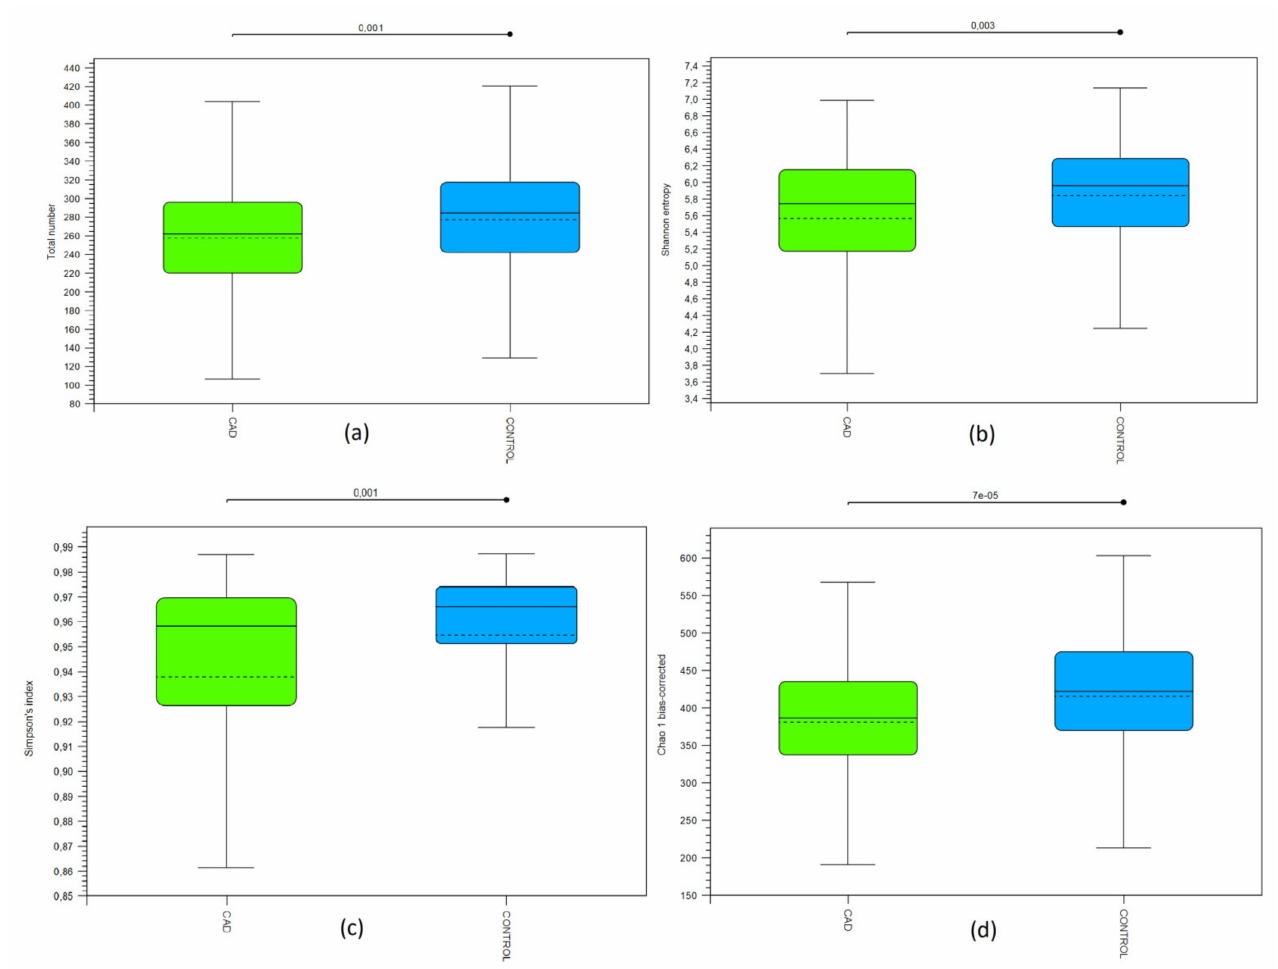
Figure 1. Alpha-biodiversity in coronary artery and control groups. CAD—coronary artery disease group. ( a ) The total amount of OTUs; OTUs—operational taxonomy units, ( b ) Shannon entropy, ( c ) Simpson Index, ( d ) Chao1bias-corrected